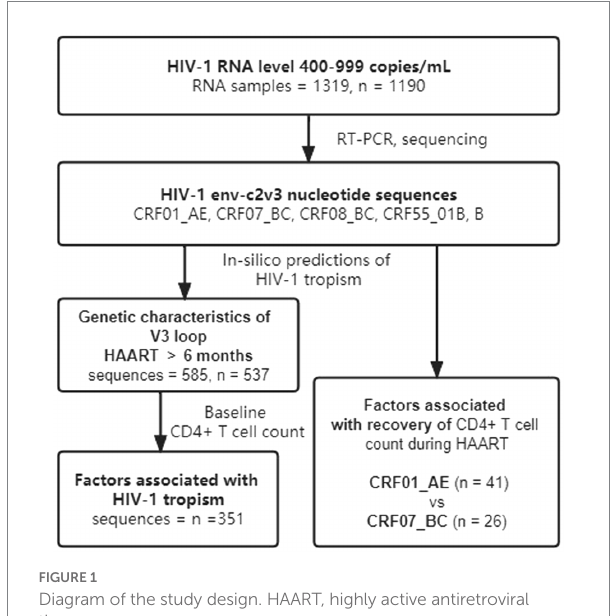
FIGURE 1 Diagram of the study design. HAART, highly active antiretroviral